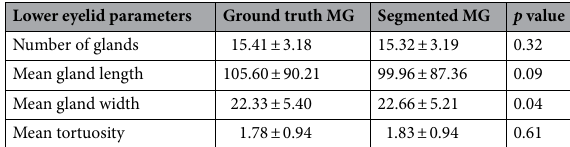
Table 2. Morphometric parameters analysis of lower eyelid. p value is between ground truth versus segmented MGs.